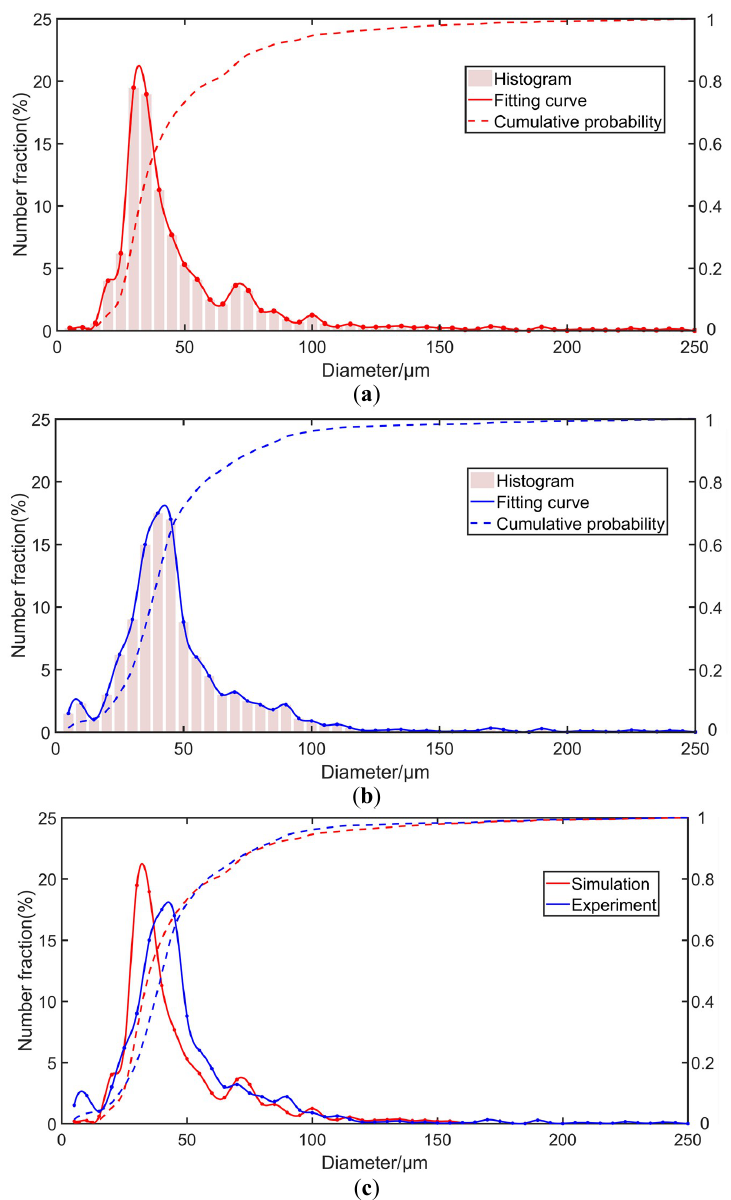
Figure 7. Droplet size distributions on the plane ( x = 150 mm): ( a ) simulation; ( b ) experiment; ( c ) comparison of simulation results and experimental data.